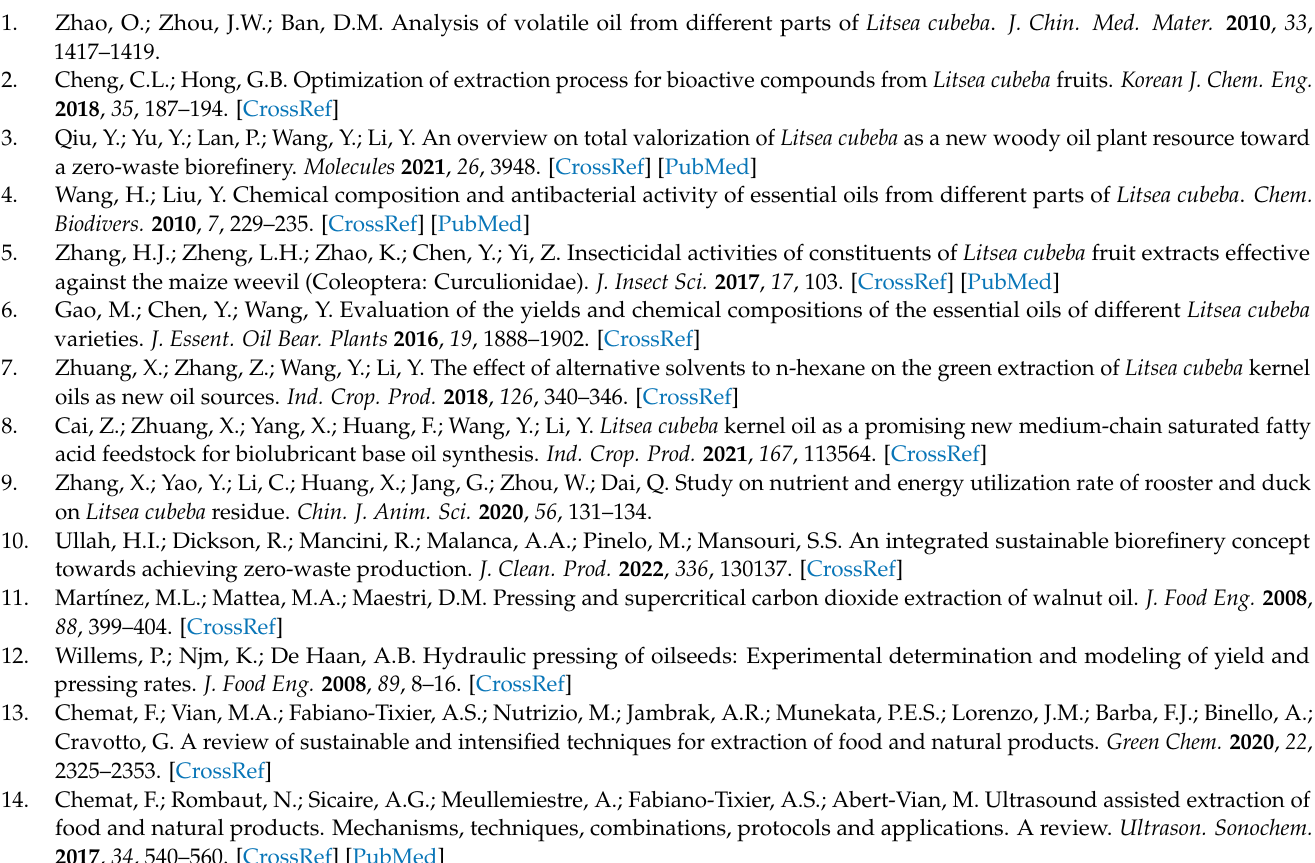
Figure S2: The decoloring effect of different dosages of activated clay on Litsea cubeba oils from (a) fruits and (b)